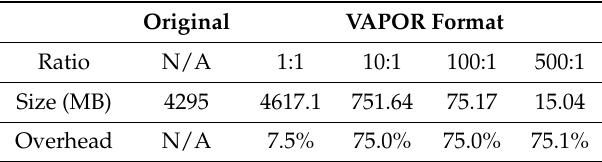
Table 4. Actual storage size and overhead in percentage of the VDC format at different lossy compression ratios. Overhead is compared against the target compression